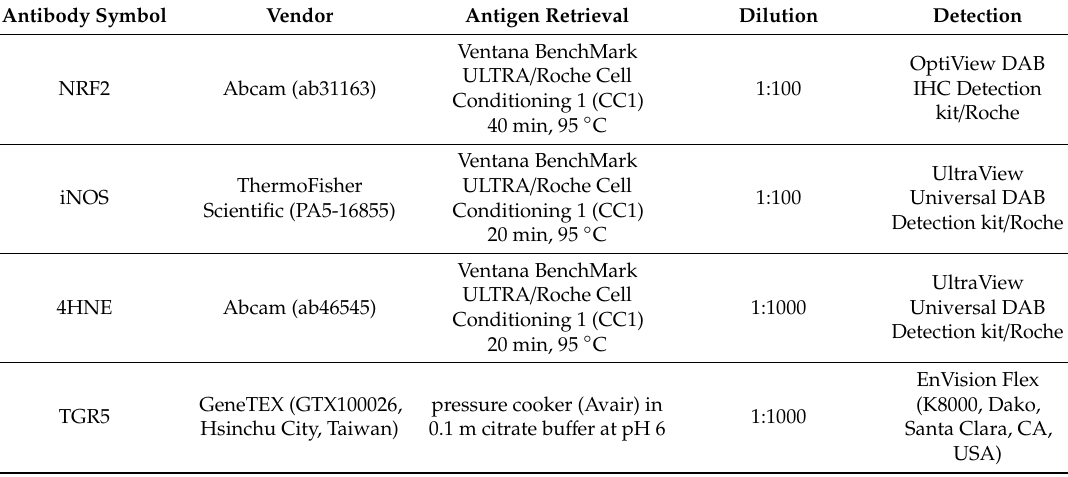
Table 3. Antibodies and conditions used in tissue microarray (TMA)